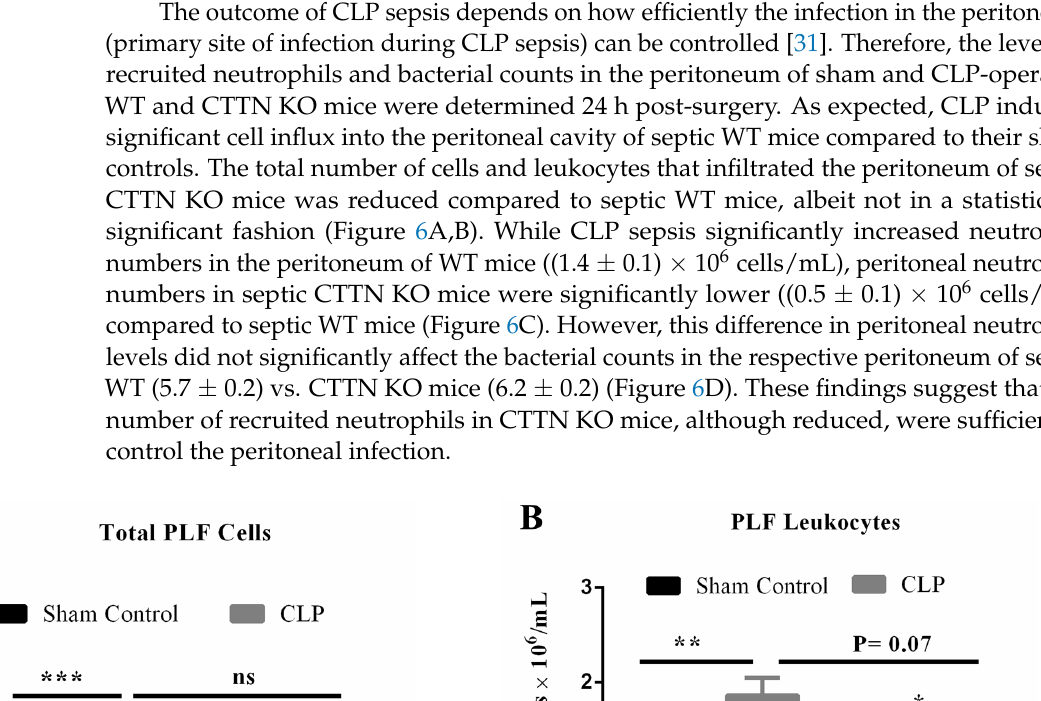
Figure 6. Cortactin deficiency prevents the excessive influx of PMN into the peritoneum without affecting bacteria count. Total numbers of peritoneal cells were counted using a Neubauer chamber ( A ). The numbers of CD45+ total leukocytes ( B ) and CD45+ LY6G+ neutrophils ( C ) in the peritoneal cavity 24 h after CLP sepsis were determined by flow cytometry. ( D ) Bacterial counts were deter- mined by inoculating serially diluted peritoneal lavage fluid (PLF) on tryptic soy agar plate and counting colony-forming units after 24 h incubation at 37 °C; dots represent the number of colony- forming units of PLF from independent mice. Data are represented as mean ± SEM of at least 5 animals per group. * p < 0.05, ** p < 0.01, *** p < 0.001. ns: non-significant. 3.7. Septic Cortactin-Deficient Mice Do Not Develop Neutropenia Major hallmarks of sepsis include leukopenia and neutropenia [26,32,33]. Reduced levels of circulating leukocytes predispose septic patients to opportunistic infections and increase the risk of developing severe sepsis. Given the reduced neutrophil transmigra- tion in CTTN KO mice, we speculated that the peripheral blood of septic CTTN KO mice would have higher leukocyte numbers compared to septic WT mice that are then available to mount a more effective intravascular immune response. CLP sepsis caused decreased levels of total peripheral blood leukocytes in septic WT and CTTN KO mice (Figure 7A). A tendency towards increased total leukocytes in the blood of septic CTTN KO mice ((0.58